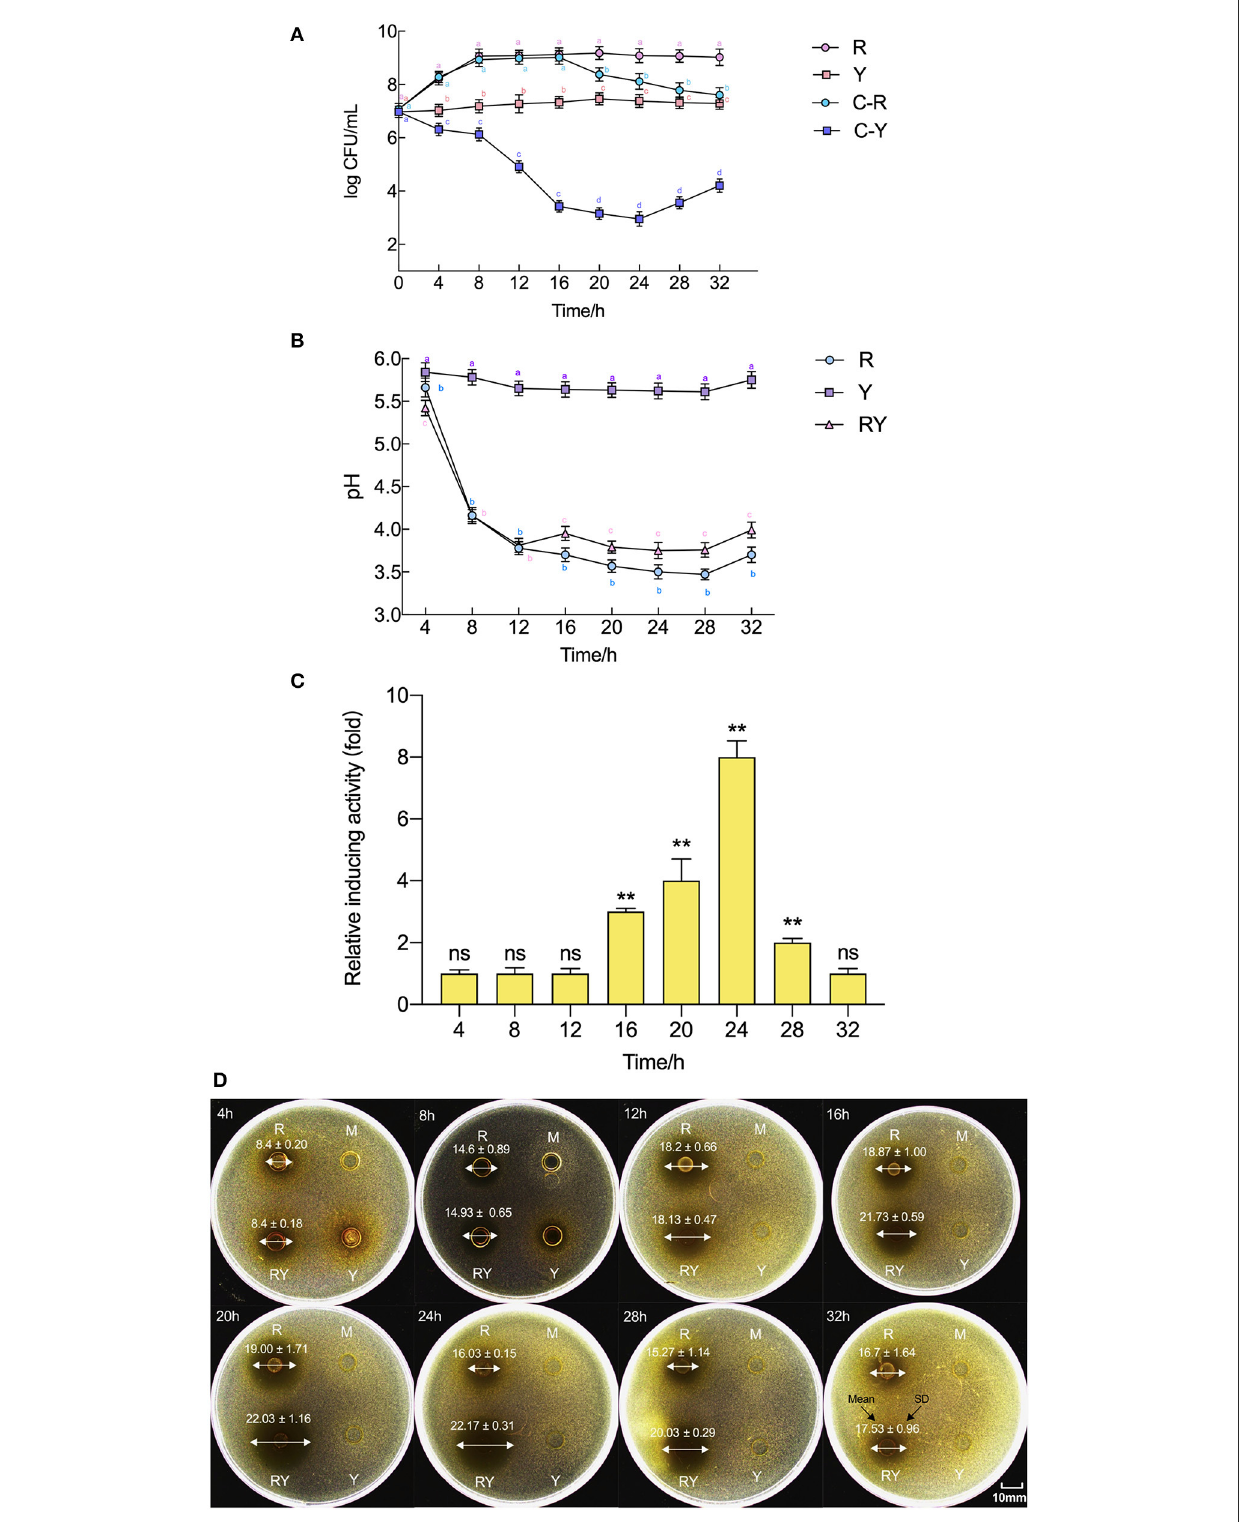
FIGURE1 Evolution of pH, plantaricin production, and viable cell counts of L. paraplantarum RX-8/ W. anomalus Y-5 in co-culture. (A) Indicates viable counts of L. paraplantarum RX-8/ W. anomalus Y-5 at every 4h from 4 to 32h in mono-culture and co-culture, (B) indicates the pH value of CFS from mono-culture and co-culture at every 4h from 4 to 32h, (C) indicates the relative inducing activity in co-culture at every 4h from 4 to 32h compared with the mono-culture, (D) were images of inhibition zone of CFSs from mono-culture and co-culture against L. monocytogenes 35152. Mean diameter of inhibition zone (mm) ± standard deviation. R means mono-culture of L. paraplantarum RX-8 at 37 ◦ C in 4–32h, Y means mono-culture of W. anomalus Y-5 at 37 ◦ C in 4–32h, RY means bacteriocin-inducing co-culture of L. paraplantarum RX-8 and W. anomalus Y-5 at 37 ◦ C in 4–32h, and M means blank control (MRS, pH 6.0). C-R means the viable cell count of L. paraplantarum RX-8 in co-culture, and C-Y means the viable cell count of W. anomalus Y-5 in co-culture. ns, not significant, * p < 0.05, ** p < 0.01. Bars with no letter in common for each treatment are significantly different ( p <